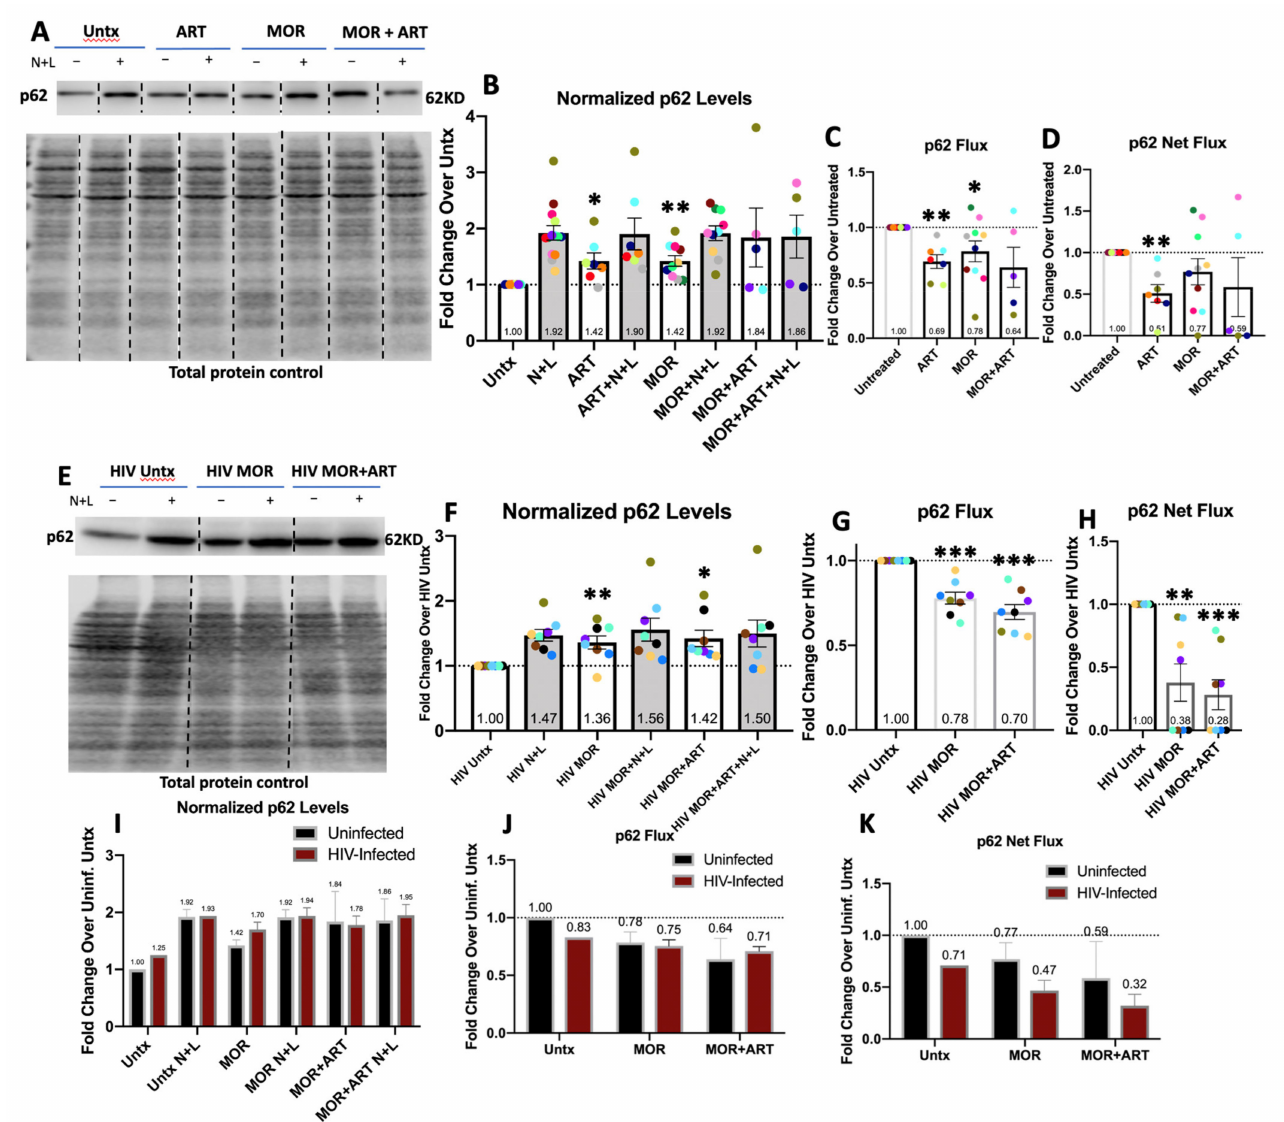
Figure 3. Normalized p62 levels, p62 flux, and p62 net flux analyzed by Western blotting in uninfected and HIV-infected macrophages. Primary human MDM were cultured as in the Materials and Methods section (Section 2) and left untreated (Untx) or treated with morphine and/or ART for 24 h with lysosomal inhibitors, NH4Cl and leupeptin (N+L) added in the last 4 h. ( A ) Representative Western blot with total protein loading control in uninfected cells. ( B ) p62 levels relative to total protein and normalized to the uninfected untreated control for each experiment. ( C ) p62 flux was quantified. ( D ) p62 net flux was quantified. ( E ) Representative Western blot with total protein loading control in HIV-infected cells. ( F ) p62 levels relative to total protein and normalized to the HIV-infected untreated control for each experiment. ( G ) p62 flux was quantified. ( H ) p62 net flux was quantified. ( I ) Normalized p62 values for infected MDM were corrected for the presence of HIV on average based on data in Supplementary Materials Figure S2 according to calculations described in the Materials and Methods section (Section 2), and comparisons were made between MOR and MOR+ART treatments in uninfected and infected cells. ( J ) p62 Flux values for infected MDM were corrected using the Normalized p62 values in ( I ) and compared to uninfected flux values. ( K ) p62 Net Flux values for infected MDM were corrected using the Normalized p62 values in ( I ) and compared to uninfected flux values. Error bars depict SEM, n = 5–10 independent experiments, * p < 0.05, ** p <0.01 one-sample t -test, *** p < 0.001 one-sample t